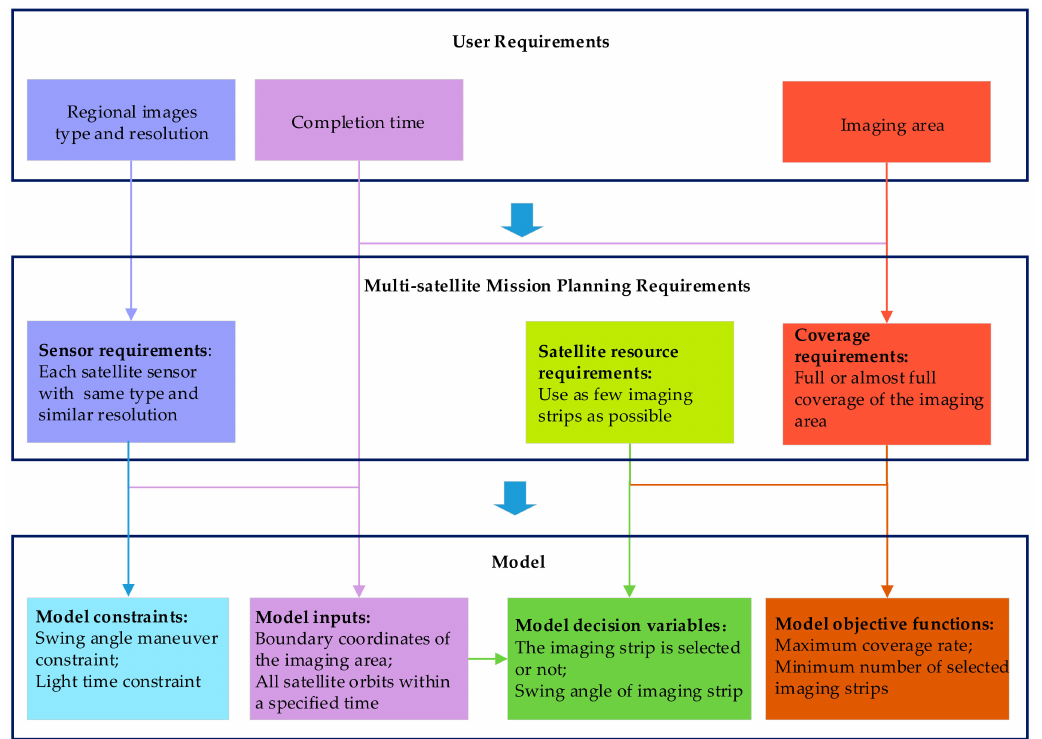
Figure 3. Transformation from requirements to planning